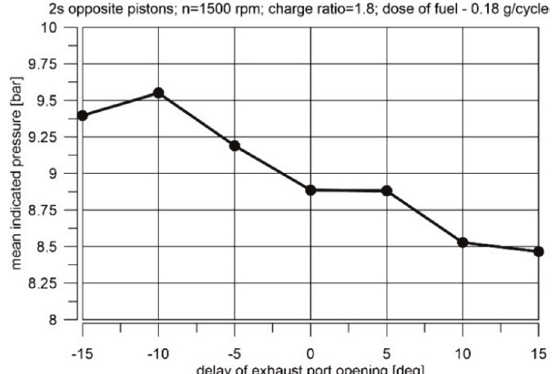
Fig. 14. Variation of mean indicated pressure in dependence of delay of exhaust port